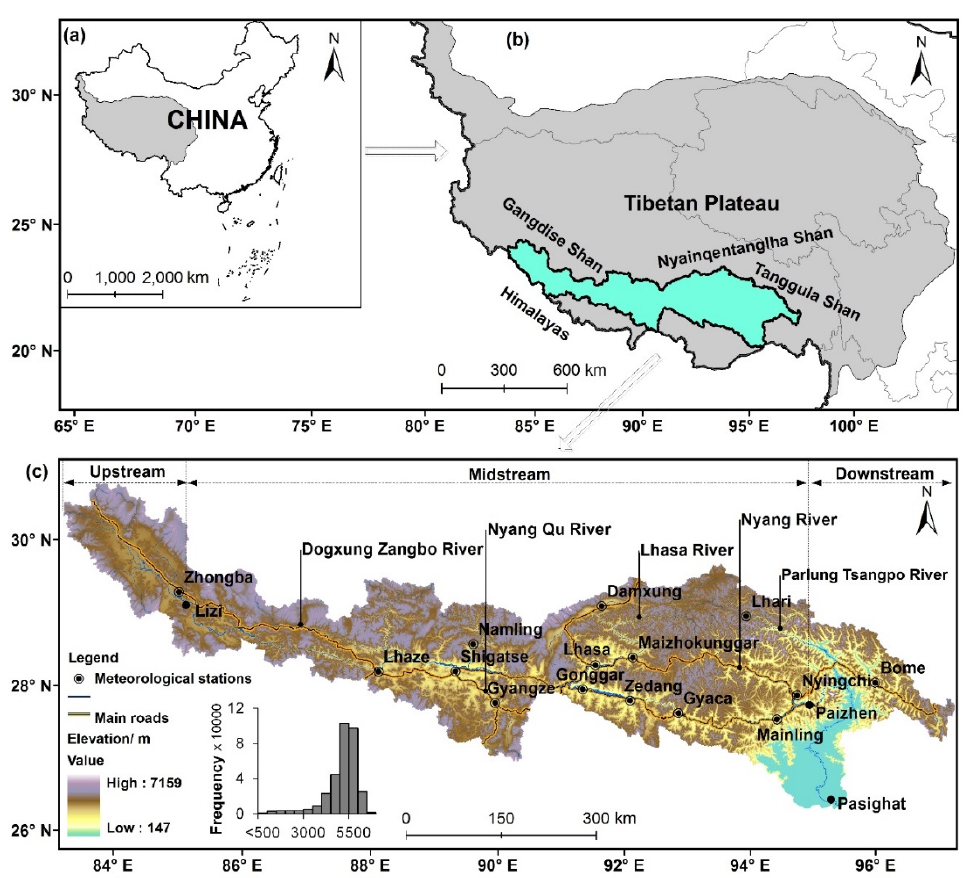
Figure 1. The geographical location of the Yarlung Zangbo River basin in the Tibetan Plateau, China ( a , b ); and its topographic characteristics represented using the 1 km resolution SRTM DEM ( c ). As no meteorological station exists in the upstream of the YZR basin, we use the nearest Gêrzê station to represent the meteorological conditions of Zhongba County.